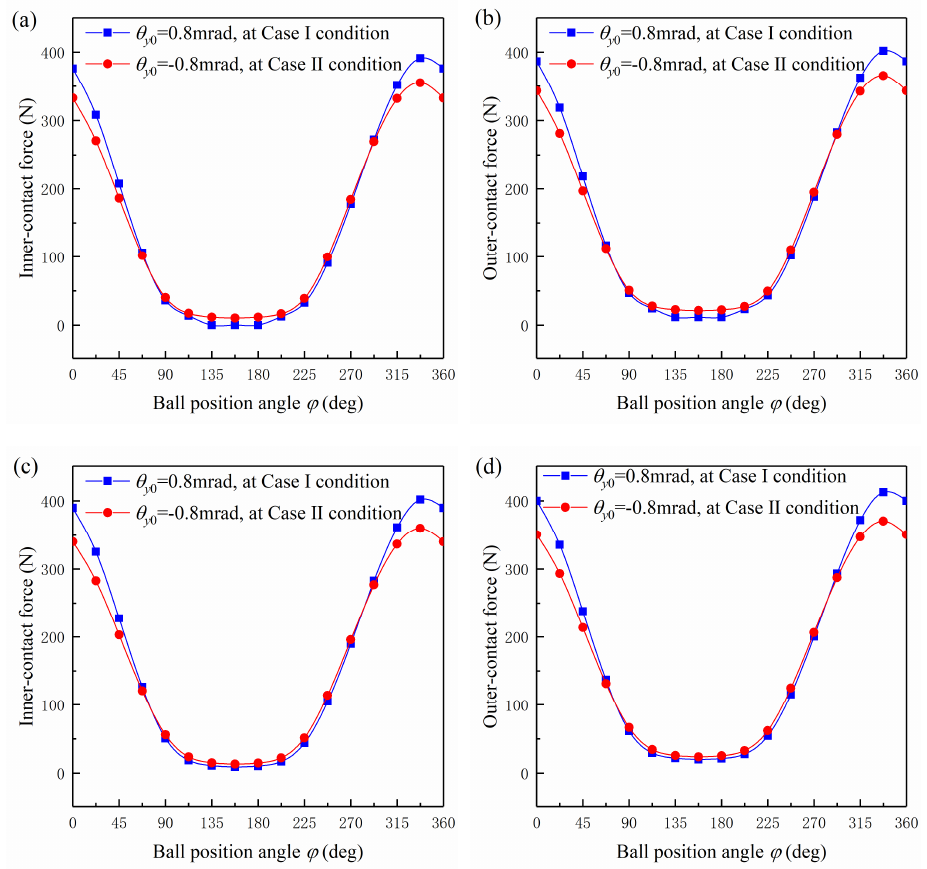
Figure 12. The contact force distribution in Rear Bearing 1 at the optimal angular misalignment of the shaft-bearing system. The preload displacements are 0.025 mm (( a ) and ( b )) and 0.035 mm (( c ) and ( d )), respectively.